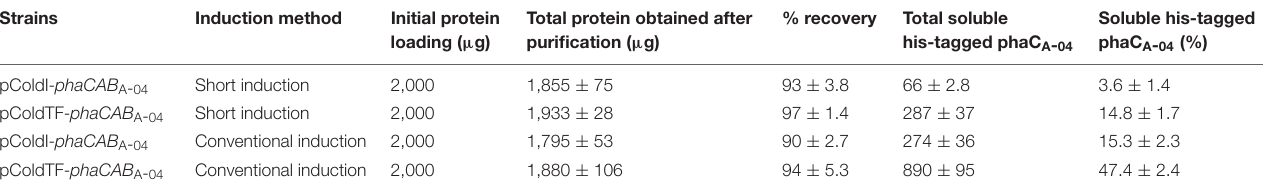
TABLE 3 | Quantification of purified soluble phaC A - 04 produced by E. coli JM109 (pColdI- phaCAB A - 04 ) and E. coli JM109 (pColdTF- phaCAB A - 04 ) under short induction method compared with the conventional method in shake flask cultivation. Strains